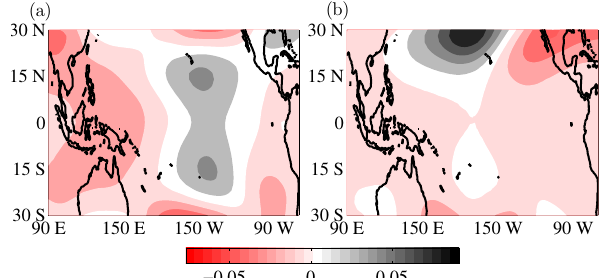
Figure 12. The first two eigenvectors of the covariance matrix (EOFs) of the NOAA reanalysis data considering the time period (1955–2009) rotated by the simplicity criterion. Variance explained: 14.9% (ENSO pattern related) (a) , 9.1% (PNA pattern related) (b) .